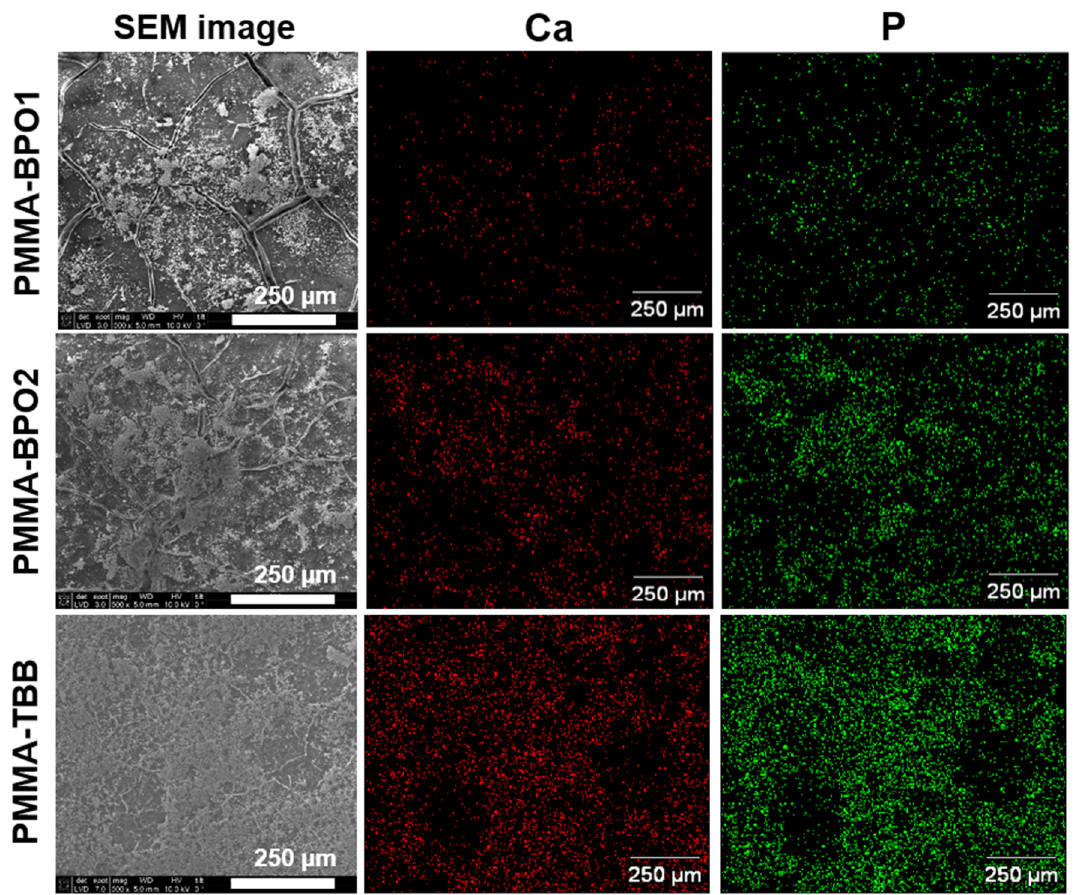
Figure 6. Morphology and chemistry of osteoblastic cultures on bone cements. Osteoblasts were cultured on seven-day-old bone cement specimens. Scanning electron microscopy (SEM) images of cultures on day 15 and the energy-dispersive X-ray spectroscopy (EDX) mapping taken from the corresponding area to detect the atomic Ca and P are presented side-by-side. Scale bar = 250 µm.